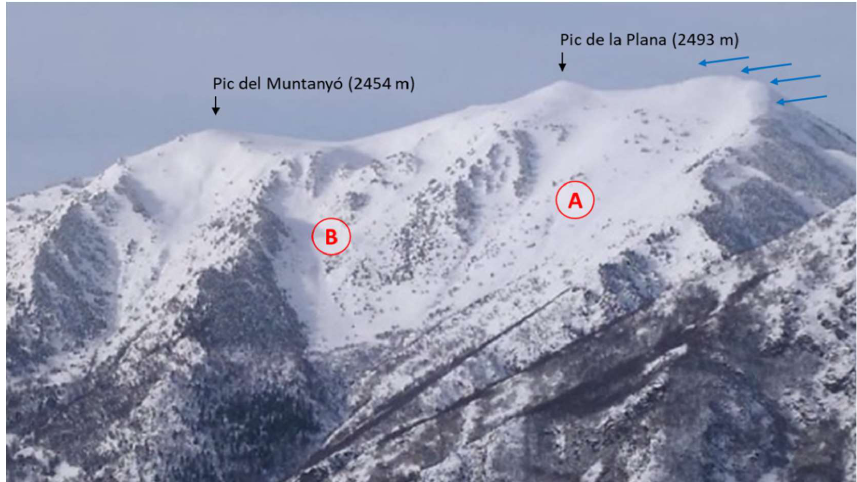
Figure 2. Starting zone of Monars avalanche path. A: Main starting zone. Its central part is the most active, being loaded with drifted snow with dominant winds coming from north and north-west (blue arrows); B: Secondary starting zone, steeper and also active, but smaller. Photo: Sara Orgué (taken after Gloria storm on 27 January 2020).